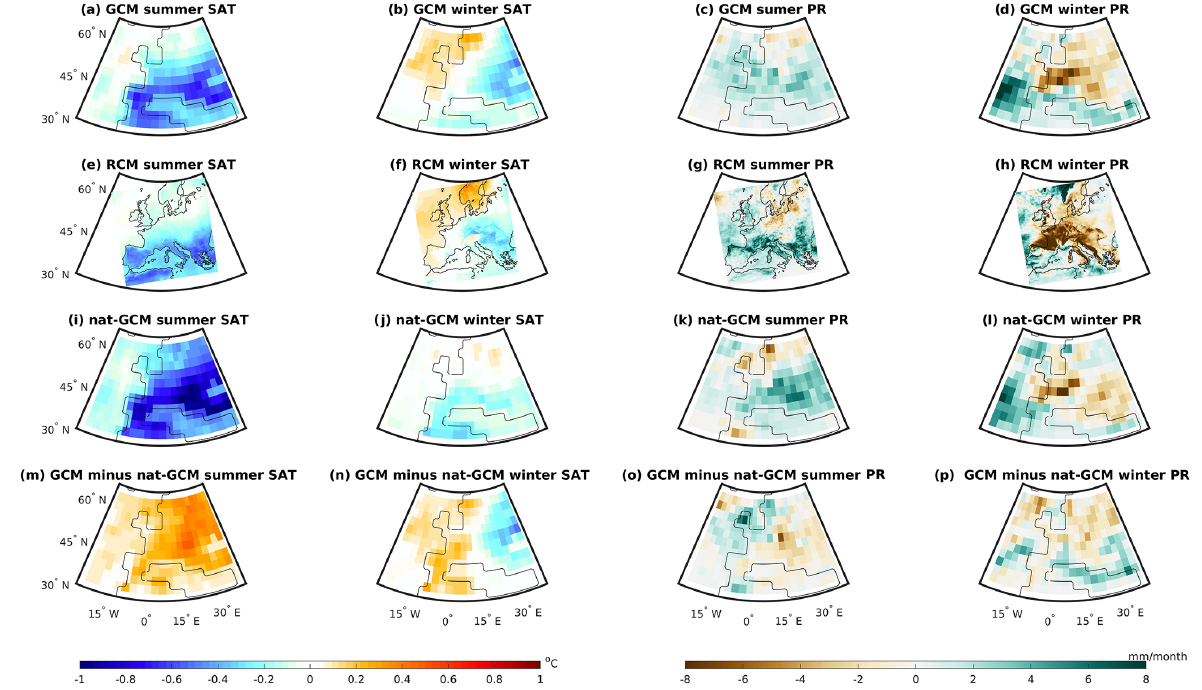
Figure 6. Multi-eruption mean surface air temperature (SAT) for the summer (a, e, i, m) and winter (b, f, j, n) and precipitation for summer (c, g, k, o) and winter (d, h, l, p) 1 year after the eruption. Shown for the GCM (a–d) , RCM (e–h) , nat-GCM (i–l) , and the residual forcing ( m–p ; GCM minus nat-GCM). Anomalies are shown relative to the 5-year period directly prior to the eruptions. The three eruptions in the multi-eruption mean are Agung, El Chichón, and Pinatubo; the years plotted are 1964, 1983, and 1992 respectively (for winter this is 1963/64, 1982/83, and 1991/92) similar to Fischer et al. (2007). Continental borders are shown for each individual model.